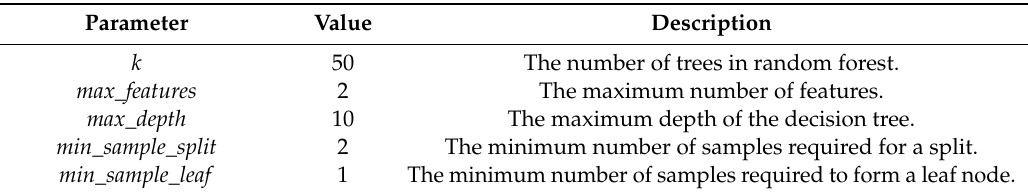
Table 3. Random Forest parameters for water quality